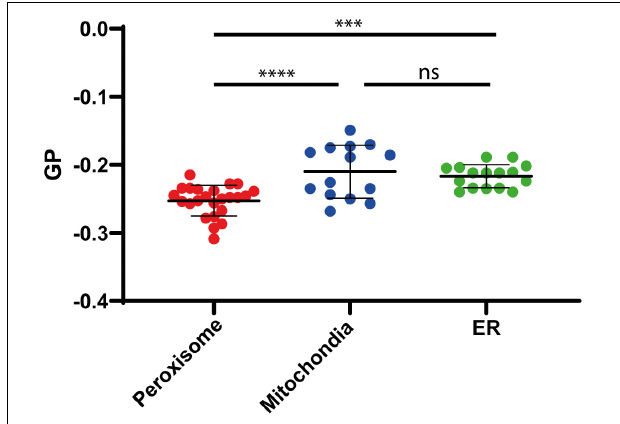
FIGURE 4 | Membrane fluidity. Generalized polarization (GP) values measured on isolated Peroxisomes (red), Mitochondria (blue), and ER (green), indicating a slightly higher fluidity (lower GP value) for peroxisomal membranes, compared to mitochondria and ER membranes. Shown are individual measurements and the mean values with standard deviation from the three independent experiments. Statistical analysis: Ordinary One-way ANOWA with multiple comparisons; **** P < 0.0001; *** P = 0.0003; ns: not